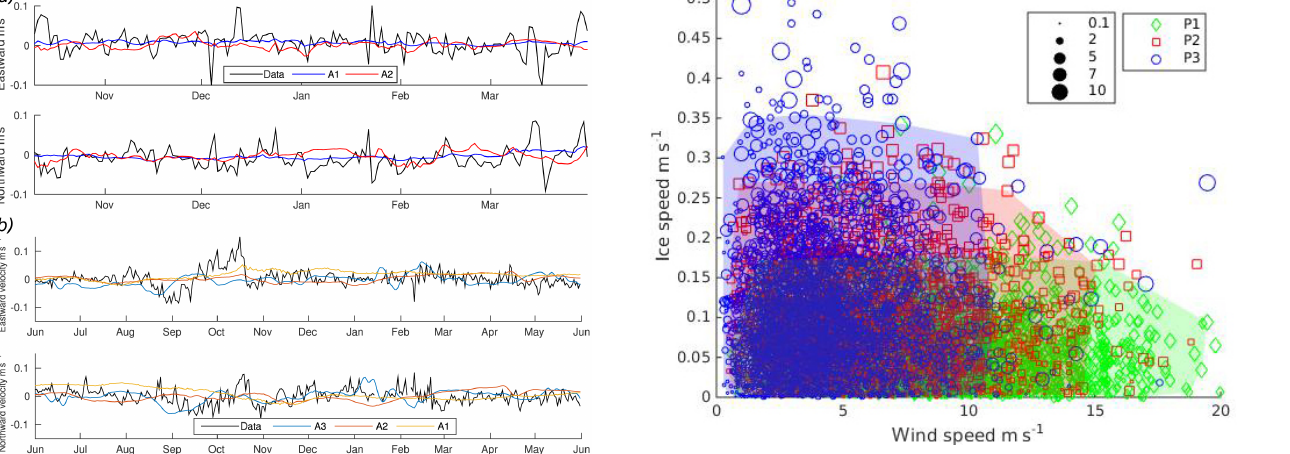
Figure 9. (a) Daily-averaged velocity components from 5 to 50m observed by ITP-V vs. those simulated by A1 and A2. (b) Daily- averaged velocity components at 25m observed by mooring D vs. A1,A2 and A3.